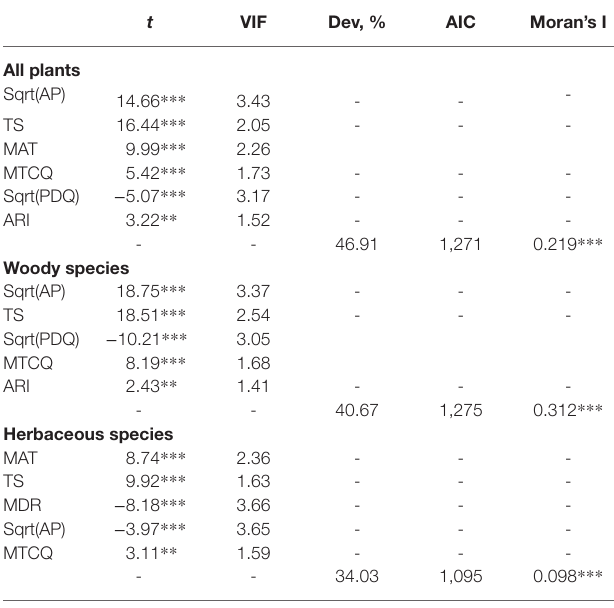
TABLE 1 | Results of multiple linear regression (OLS) models for all environmental variables and the proportion of total, woody, and herbaceous samara species to total